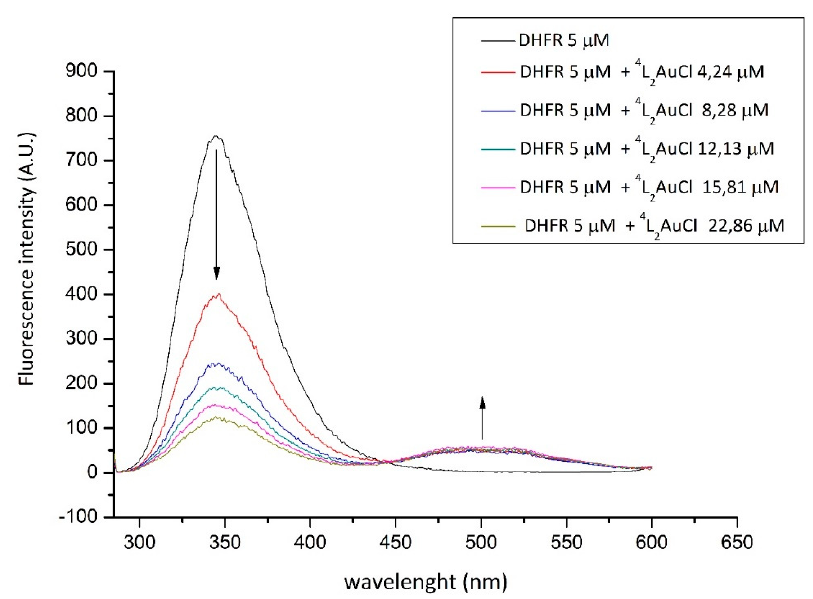
Figure 5. DHFR’s tryptophan emission quenching upon stepwise additions of 4 L 2 AuCl ( λ exc = 280 nm). In the inset legend, the color corresponds to the curve and the respective concentrations.